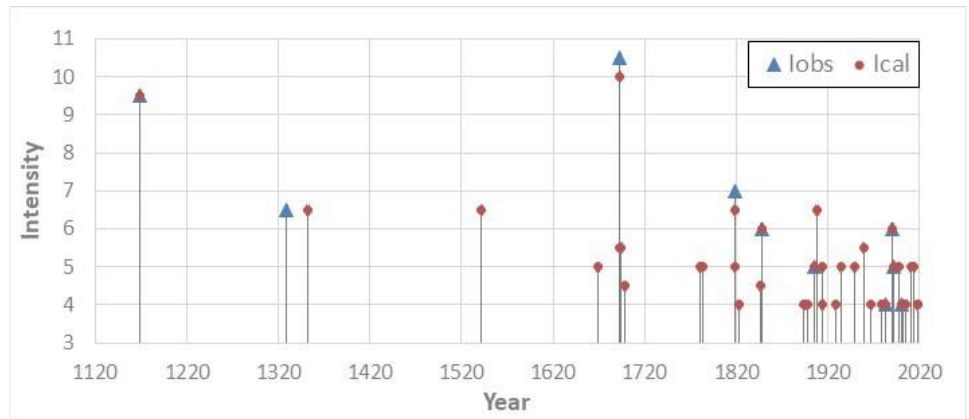
Figure 4. Seismic history of Aci Castello (Sicily) in the last 1000 years from intensity IV. Iobs is ob- served intensity; Ical is calculated